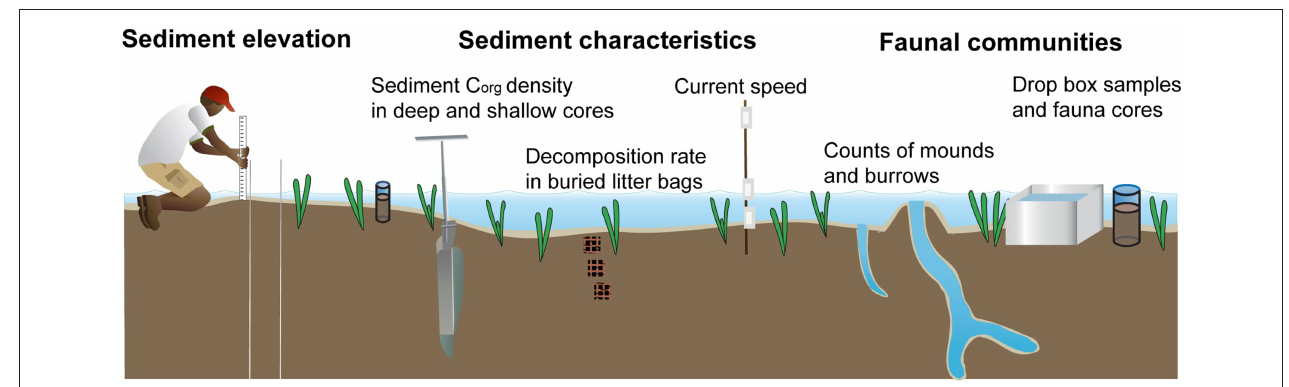
FIGURE 4 | Combined layout of the experimental set up (Images adjusted from: ian.umces.edu/symbols).